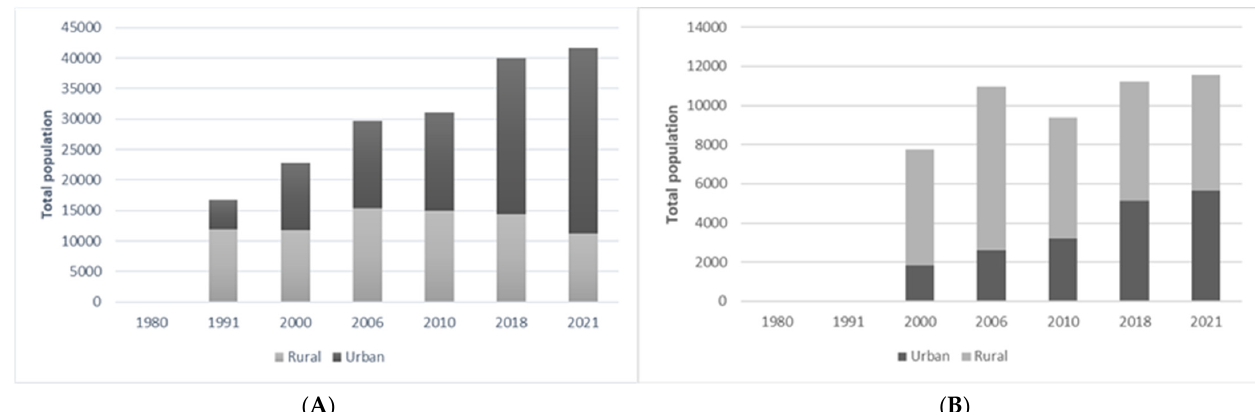
Figure 8. Population growth in urban and rural areas, ( A ) Machadinho settlement and ( B ) Anari settlement [61].